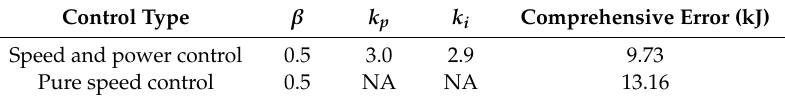
Table 3. Optimization results of di ff erent control types.